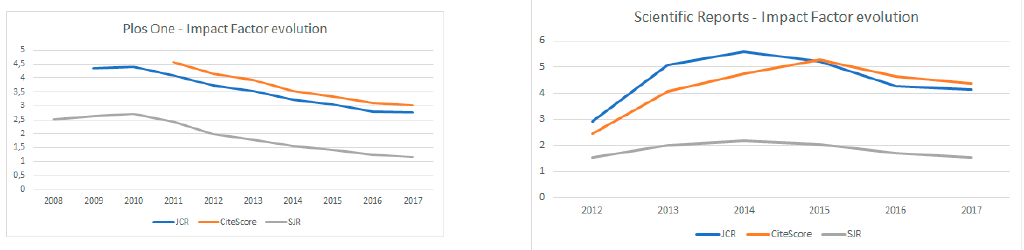
Figure 8. Graph with evolution of Impact Factor for PLoS One and Scientific Reports.